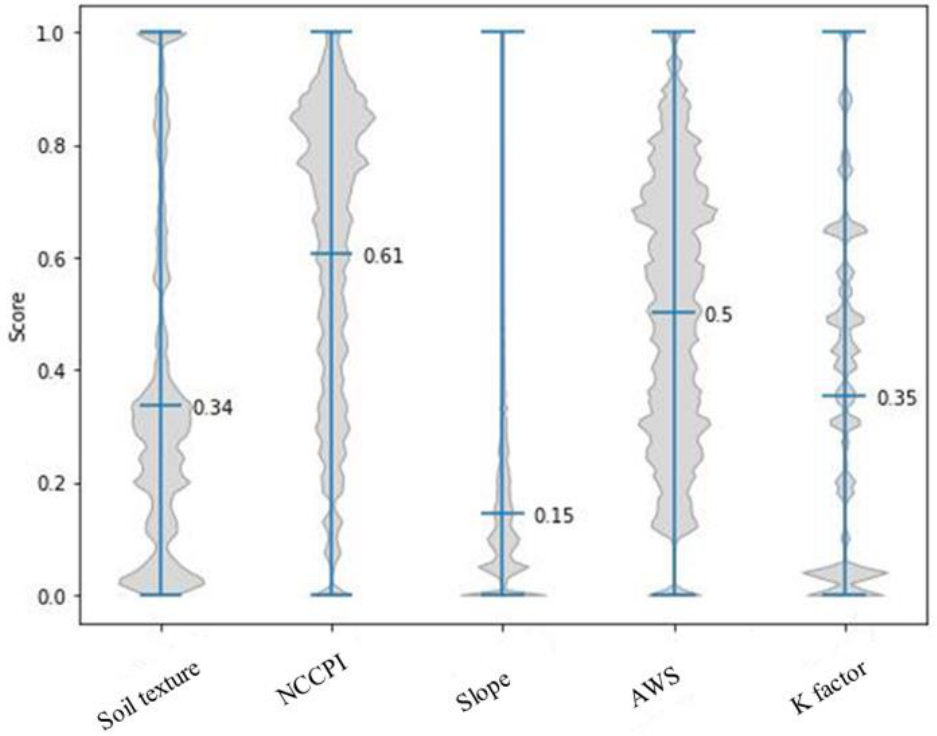
Figure 7. Violin plots showing data distributions of individual criteria with continuous scoring func- tions.